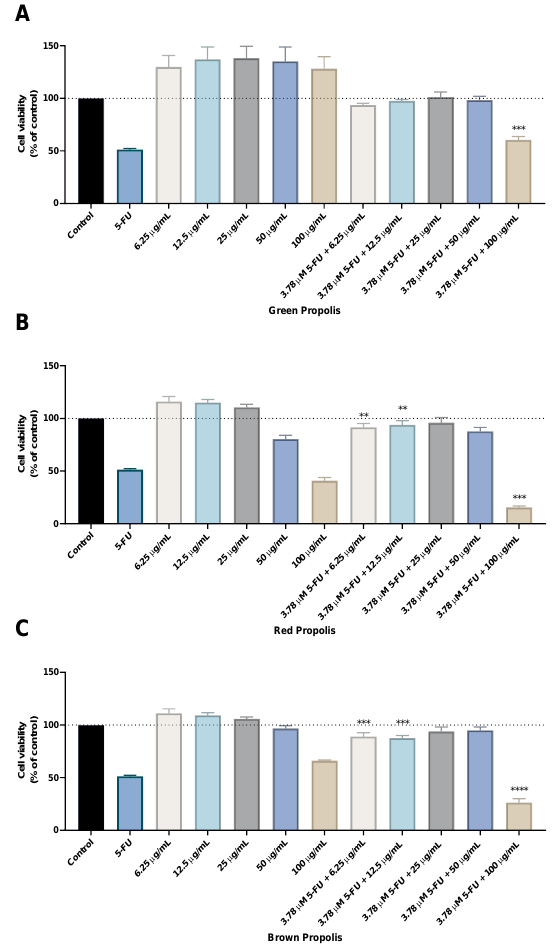
Figure 4. Cell viability of HT-29 colon cancer cells treated with the combination of different propolis extracts and 5-FU. Cultured cells were seeded in 96-well plates and exposed to increasing concen- trations of each propolis extract combined with the IC 50 value of 5-FU (3.78 μM) for 48 h. Cell via- bilities were determined after the final treatment by MTT. The drugs in combination were co-ad- ministered at the same time. ( A ) The effect of 5-FU plus green propolis on cell viability. ( B ) The effect of 5-FU plus red propolis on cell viability. ( C ) The effect of 5-FU plus brown propolis on cell viability. Each point represents the mean ± SEM relative to the control untreated cells. ** statistically signifi- cant vs. control at p < 0.01. *** statistically significant vs. control at p < 0.001. **** statistically signifi- cant vs. control at p < 0.0001. The results regarding the green propolis combination with 5-FU demonstrate an en- hancement of the in vitro cytotoxic effect compared to green propolis alone, for all con- centrations. Nevertheless, only the results for the combination of 5-FU with the highest concentration of green propolis (100 μg/mL) yielded a statistical difference, with about 50% of viable cells. The combination of red propolis with 5-FU also produced promising results, especially for the combination of 3.78 μM with red propolis at a concentration of 100 μg/mL, where it was found that this drug combination resulted in significantly less viable cells than both 5-FU and red propolis alone at 100 μg/mL. Results regarding the combination of brown propolis with 5-FU also yielded a lower number of viable cells than brown propolis and 5-FU alone, particularly when combining 3.78 μM of 5-FU with 100